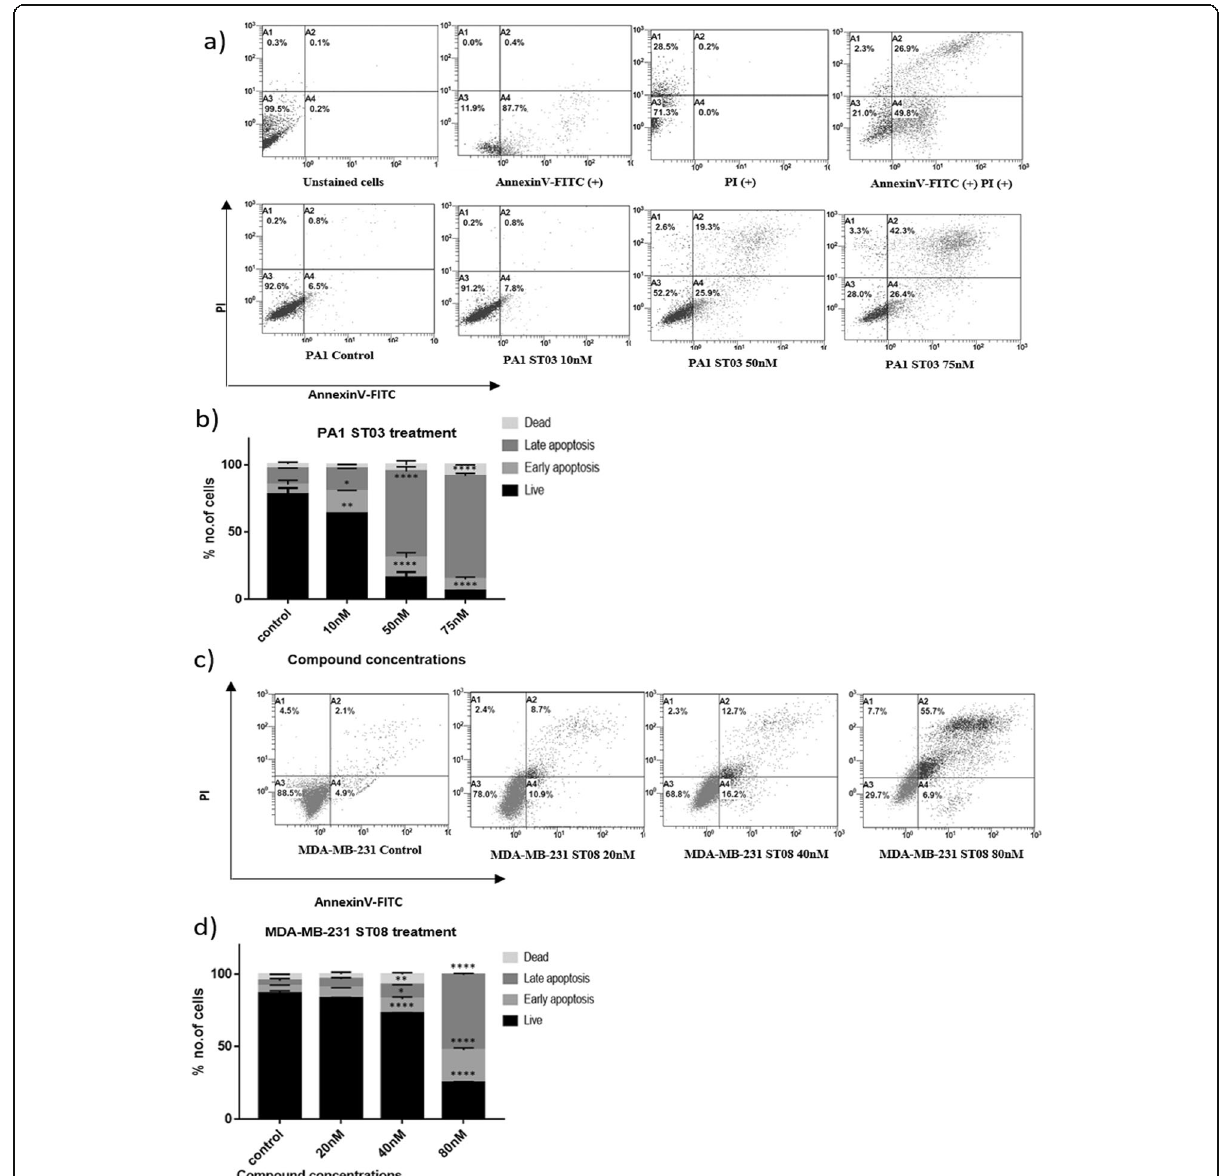
Fig. 5 Evaluation of cell death by ST compound treatments using AnnexinV-FITC/PI. a ST03 treated PA1 cells stained with Annexin/FITC-PI and b Quantification of percentage of cells in each stage c ST08 treated MDA-MB-231 cells stained with Annexin/FITC-PI and d) Quantification of cells in each stage. Each experiment was repeated for a minimum of 3 times and plotted as bar graphs with error bars. Two-way ANOVA was conducted and the p value was calculated between control and ST03 treated groups, where, *: p value < 0.05, **: p value < 0.005, ***: p value < 0.0001, ****: p value <